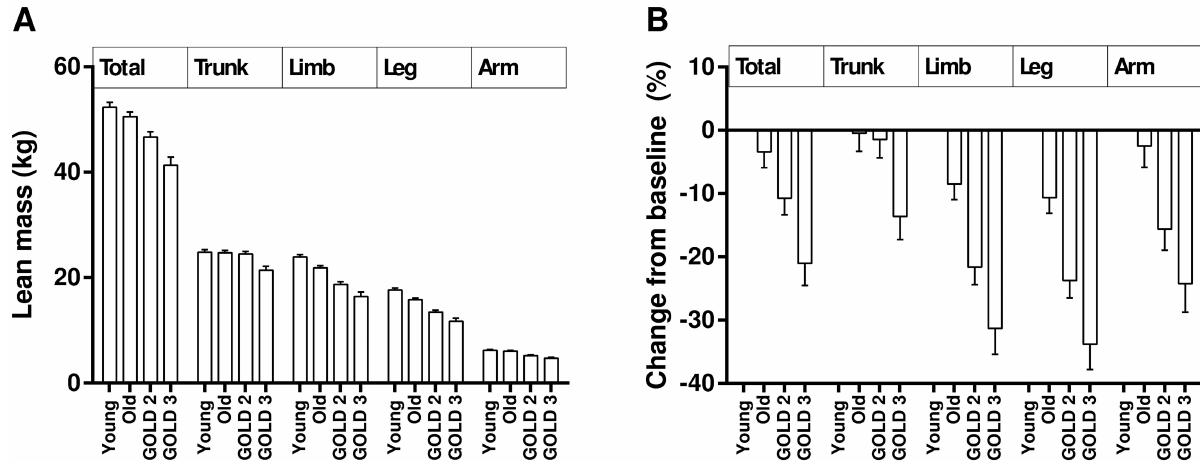
Fig 1. Changes in lean mass variables. (A) Total and segmental lean mass changesamong groups. (B) Percentage changesof total and segmentallean mass variablescompared with the healthyyoung adult group. Data were expressedas mean ± standard error of